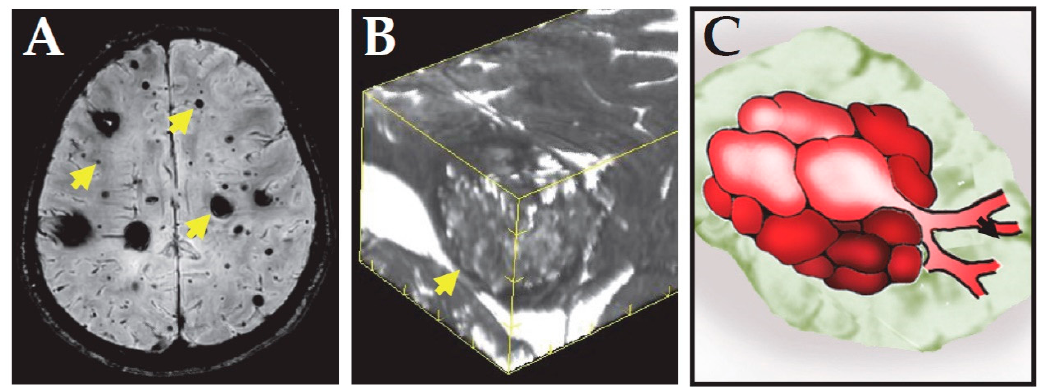
Figure 1. Radiological presentation of CCM . ( A ) MRI image of the brain of a familial CCM patient. Susceptibility weighted imaging showed multiple dark CCM lesions with various sizes. Arrows indicate representative lesions. ( B ) 3D reconstruction of T2 weighted imaging of a CCM lesion. It shows the lesion is not uniform, but with popcorn appearance. The arrow indicates the location of the lesion. ( C ) Schematic presentation of a CCM lesion showing it is composed of nested dilated microvessels.